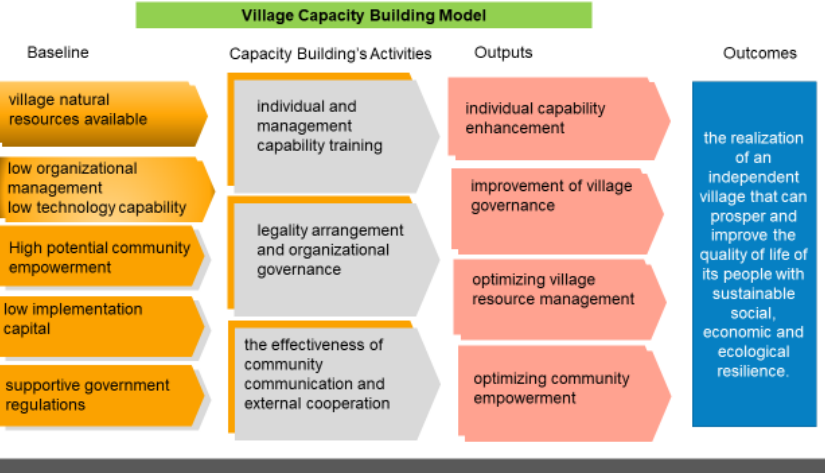
Figure 2: Village Capacity Building Model Evolving towards Sustainable Independent